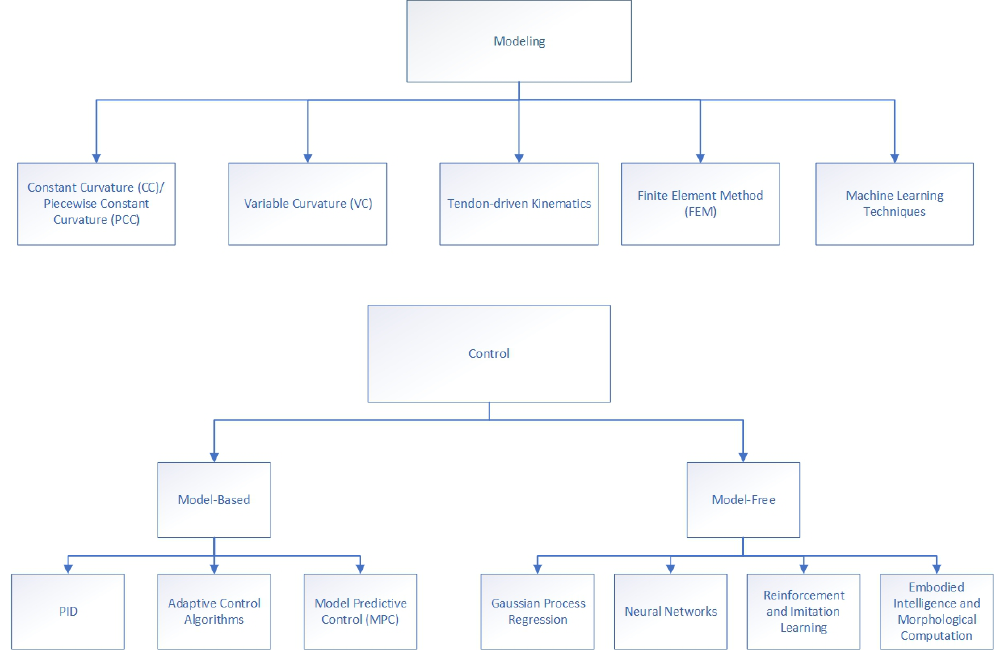
Figure 2. An overview of the different modeling and control techniques used in soft